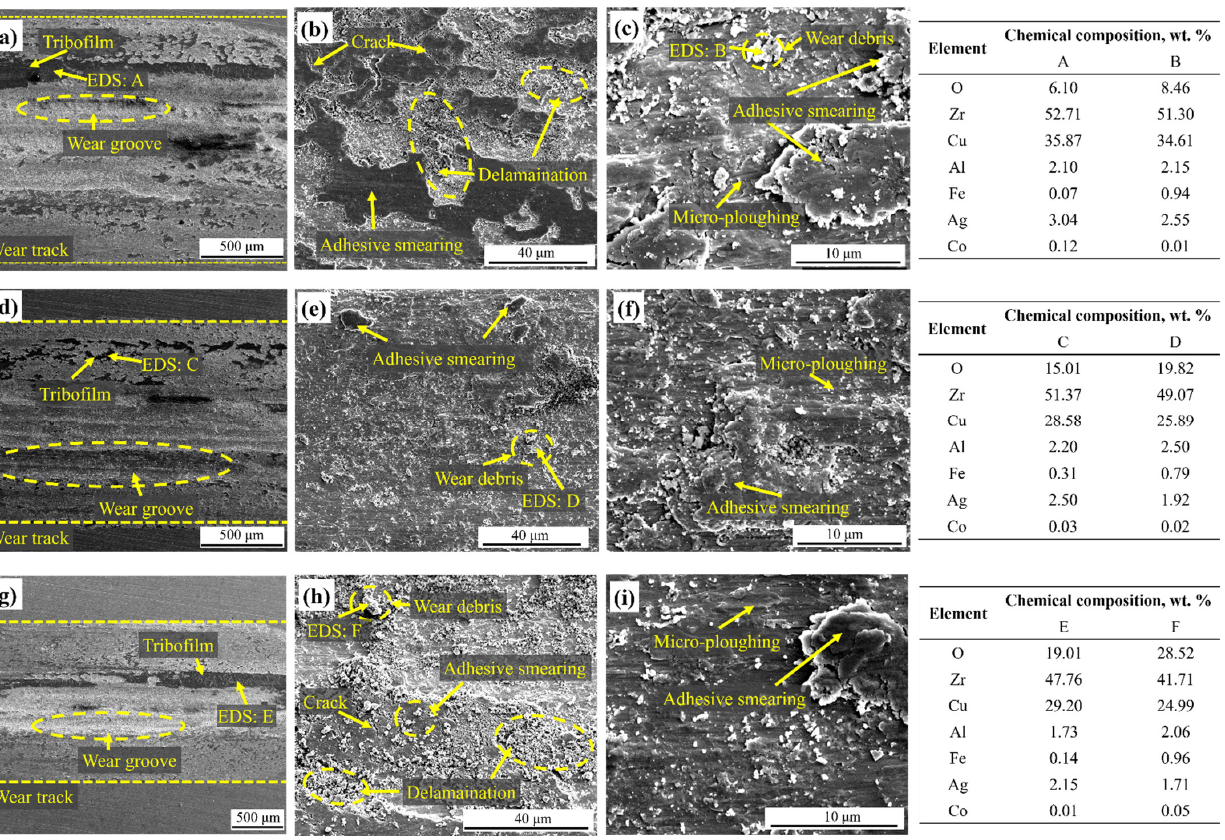
Figure 11. SEM images of wear tracks and the EDS elemental analysis of the wear surfaces of the coatings, ( a – c ) S1, ( d – f ) S2, and ( g – i ) S3.